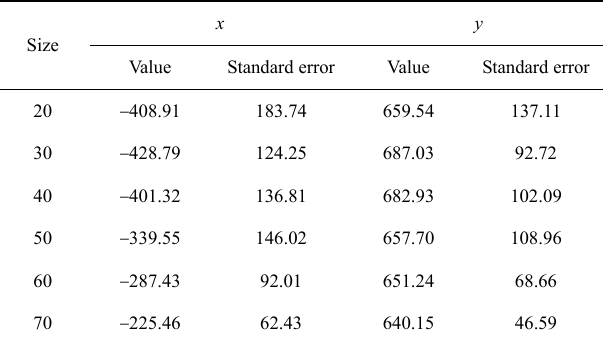
Table 2 Fitting parameters x and y for Au 0.50 Fe 0.50 alloy with different sizes.